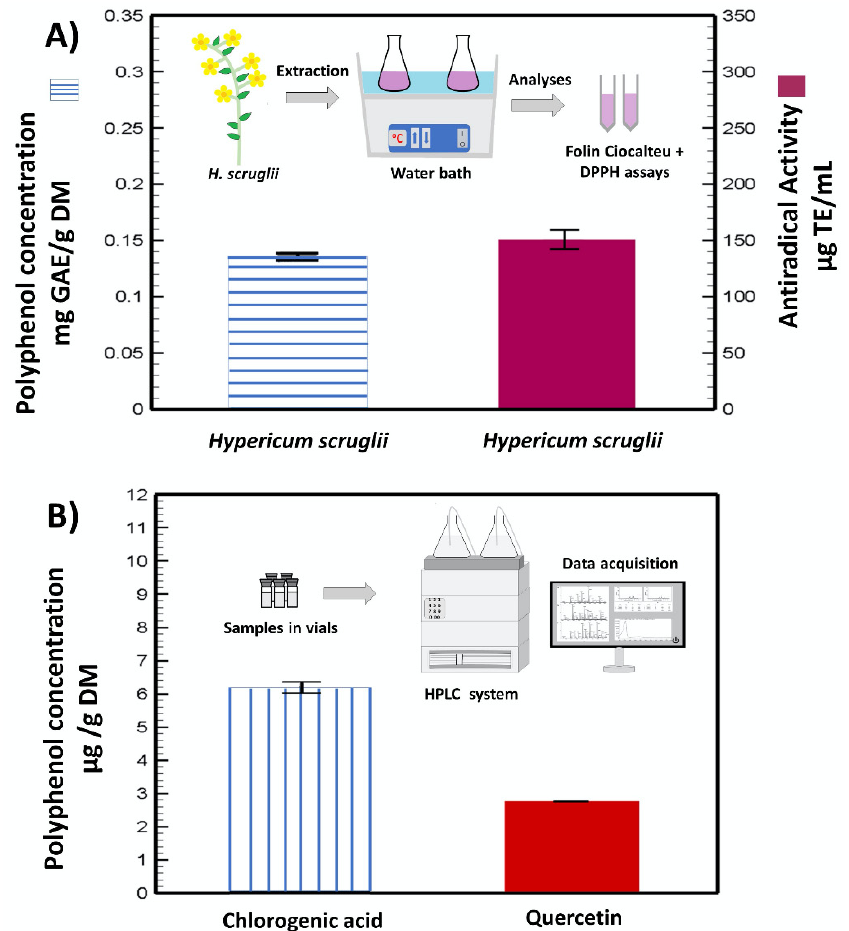
Figure 1. Polyphenol concentration and antiradical activity of the H. scruglii extract (inset shows the schematic representation of the process) ( A ), and chlorogenic and quercetin concentrations identified by HPLC (inset shows the schematic representation of the HPLC method) ( B ).